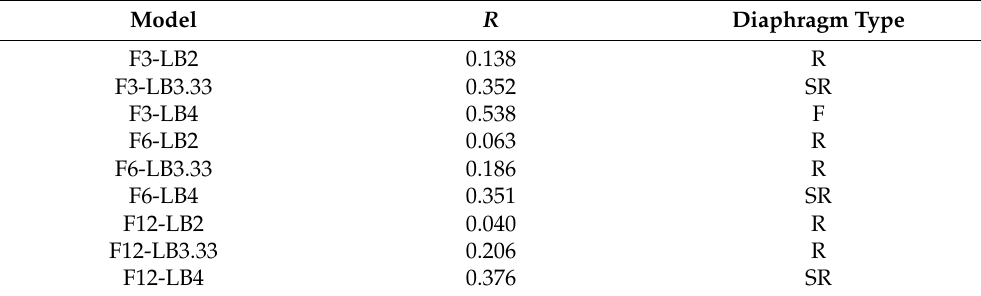
Table 4. Assessment of diaphragm